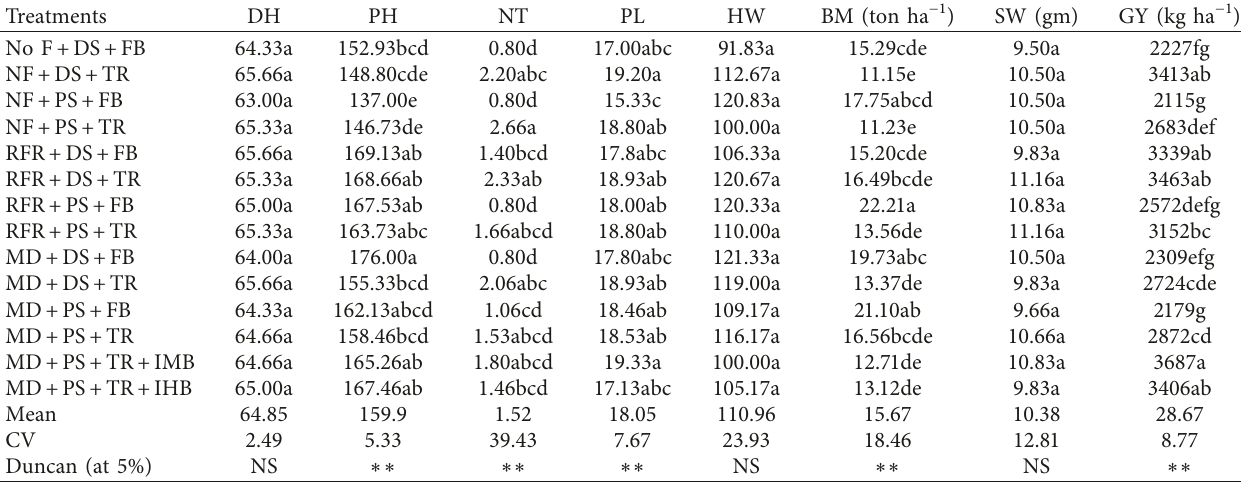
Table 3: Effect of integrated technologies on the productivity of pearl millet at Aybra in the 2014 main cropping season.